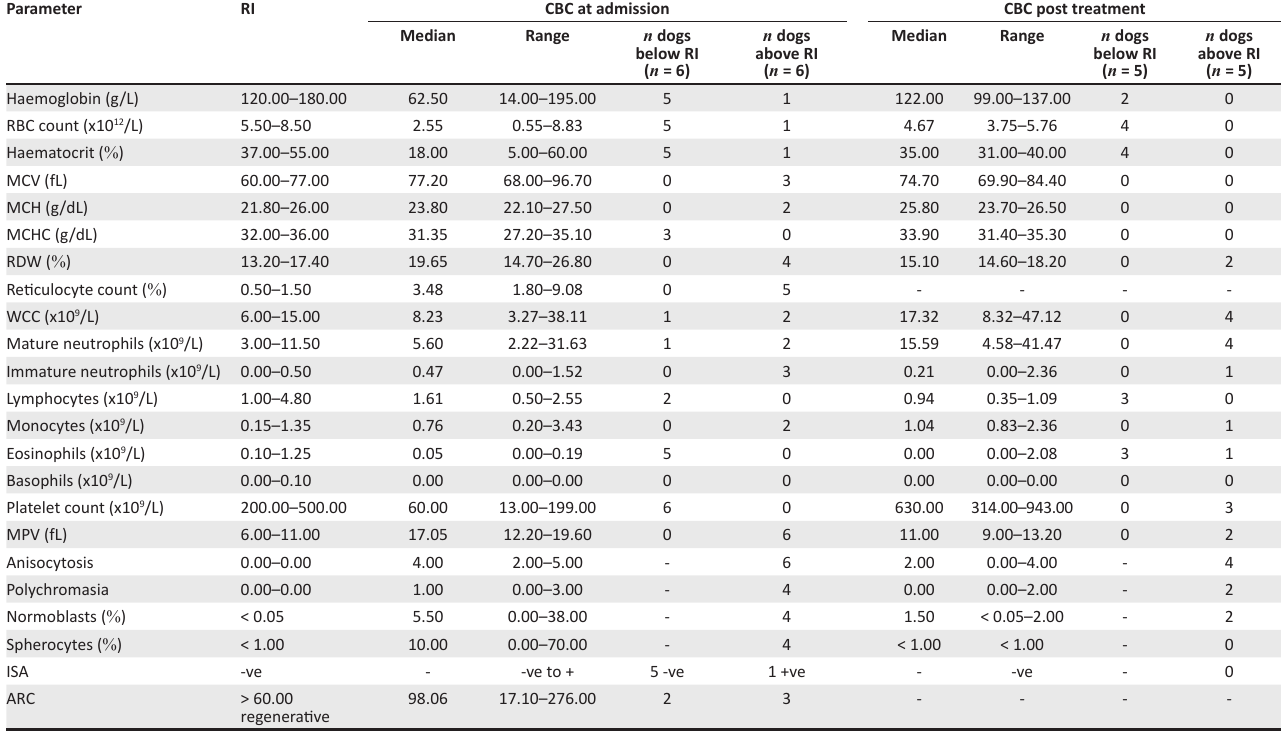
TABLE 2: Description of the haematological parameters at admission and post-treatment of dogs with theileriosis. Parameter RI CBC at admission